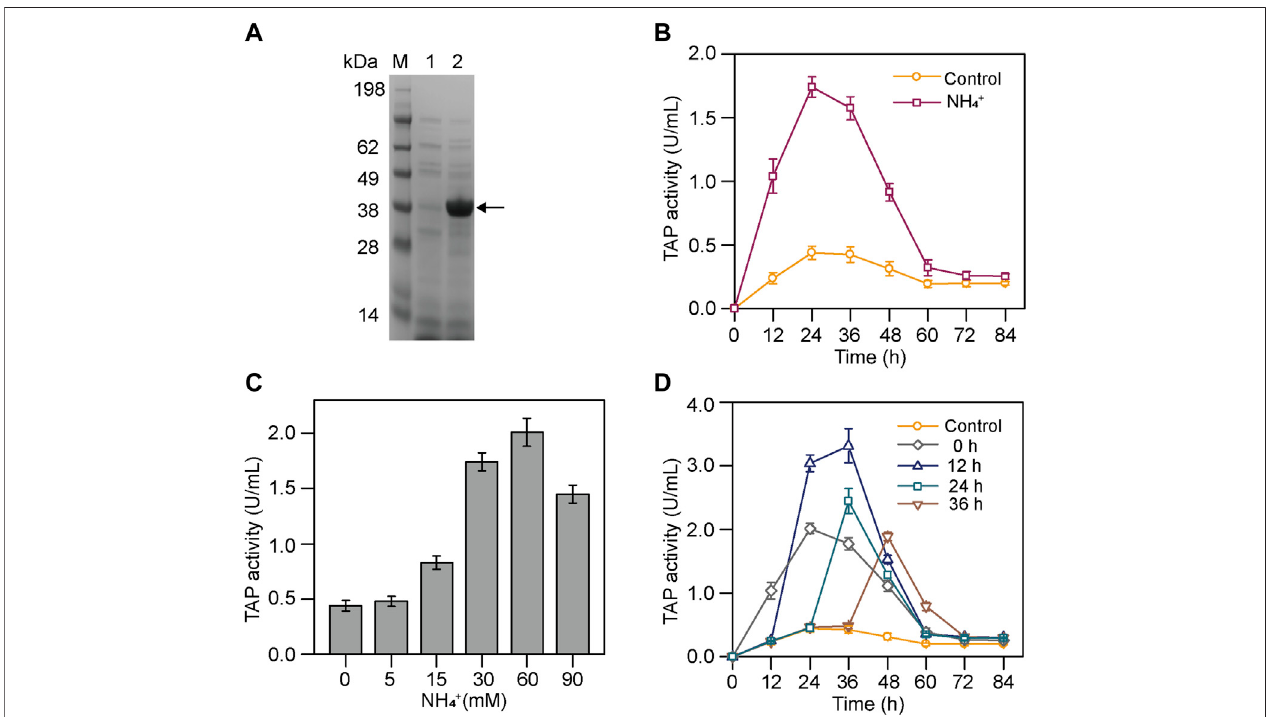
FIGURE2| Effects ofNH 4+ ontheTAPactivity insmY2019 Δ tg . (A) SDS-PAGE analysisofculturesupernatantafter cultivation for84 h. Lane 1:smY2019 Δ tg ;lane 2: smY 2019. The TGase band is indicated with single arrows. (B) Time course of TAP activity in smY2019 Δ tg with or without 30 mM NH 4+ addition. (C) Effect of NH 4+ concentration on the TAP activity in smY2019 Δ tg . The culture supernatant from the cultivation for 24 h was used for TAP activity determination. (D) Effect of NH 4+ addition time on TAP activity during the culture process at a constant NH 4+ concentration of 60 mM. NH 4+ was added in the form of (NH 4 ) 2 SO 4 .